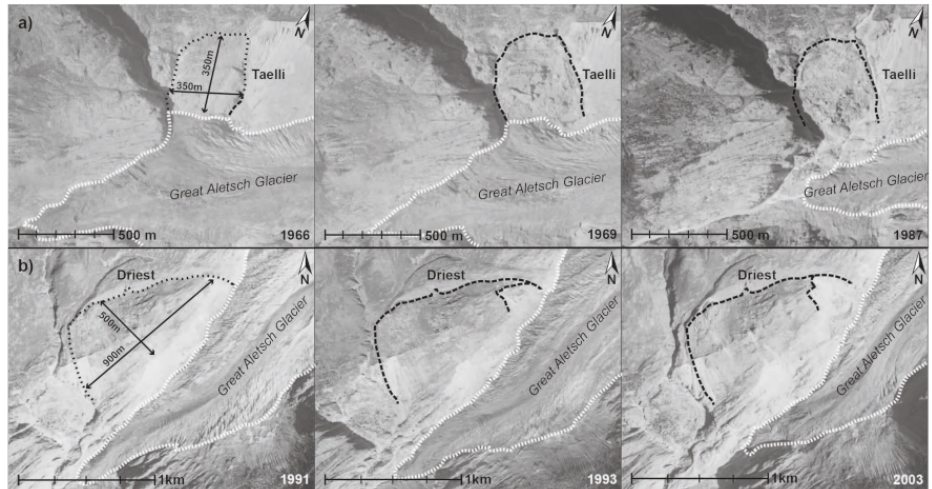
Figure 2. The two rock slope instabilities on the northern valley flank of the Great Aletsch Glacier. ( a ) The Taelli instability, which started its movement in 1966 with a distinct head scarp, developed a lateral release area upslope and collapsed in 1970 at a time when the glacial ice frees the foot of the sliding mechanism slope. ( b ) The Driest instability with its distinctive white, fresh rock band at the head-scarp was reactivated in 1993 when it developed a lateral release area upslope. Current RTS monitoring data reveal a displacement rate of several tens of millimeters/year. Images: Federal Office of Topography